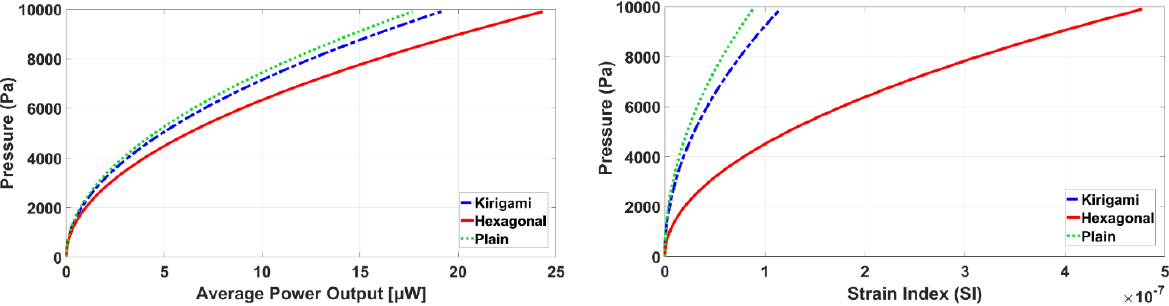
Figure 14. Average power output ( left ) and strain performance ( right ) against pressure all sensors.